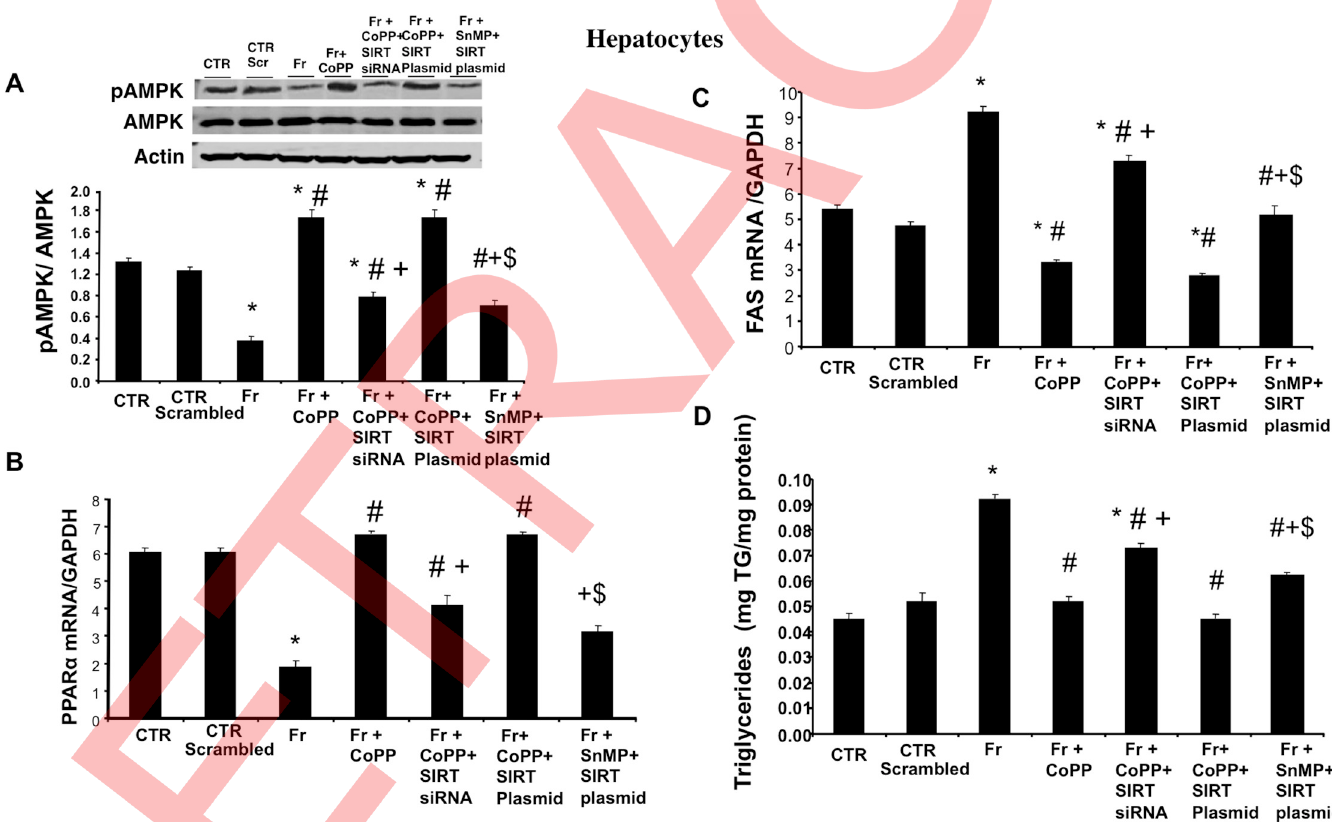
Fig 2. Effect of CoPP with and without SIRT1-siRNA, and with and without SIRT plasmid on pAMPK, PPAR α , FAS expression and triglyceride levels in fructose (Fr)-treated hepatocytes. (A) pAMPK/AMPK expression by western blot analysis. (B) PPAR α mRNA levels. (C) FAS mRNA levels measured by RT-PCR in hepatocytes. Results are mean ± SE, n = 4/group. � p < 0.05 vs CTR; # p < 0.05 vs HFr, + p < 0.05 vs HFr+CoPP, $ vs Fr+CoPP+SIRT Plasmid. (D) Triglyceride levels measured by RT-PCR in hepatocytes. Results are mean ± SE, n = 4/group. � p < 0.05 vs CTR; # p < 0.05 vs HFr, + p < 0.05 vs HFr+CoPP, $ vs Fr+CoPP+SIRT Plasmid.